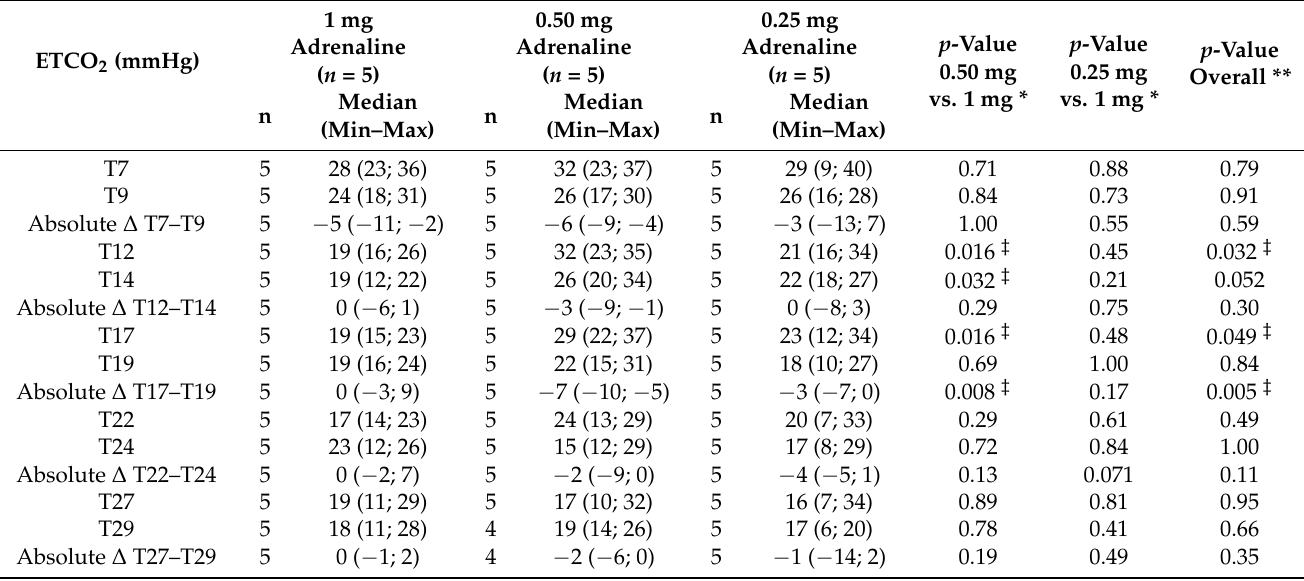
Table 4. EtCO 2 variations before and after adrenaline